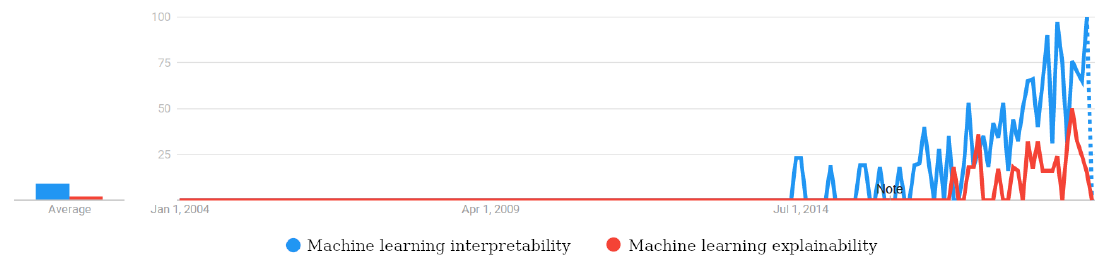
Figure 1. Google Trends comparison between the terms “machine learning interpretability” and “machine learning explainability” from January 2004 until May 2019. The vertical axis refers to the relative popularity, where 100 is the popularity peak for the